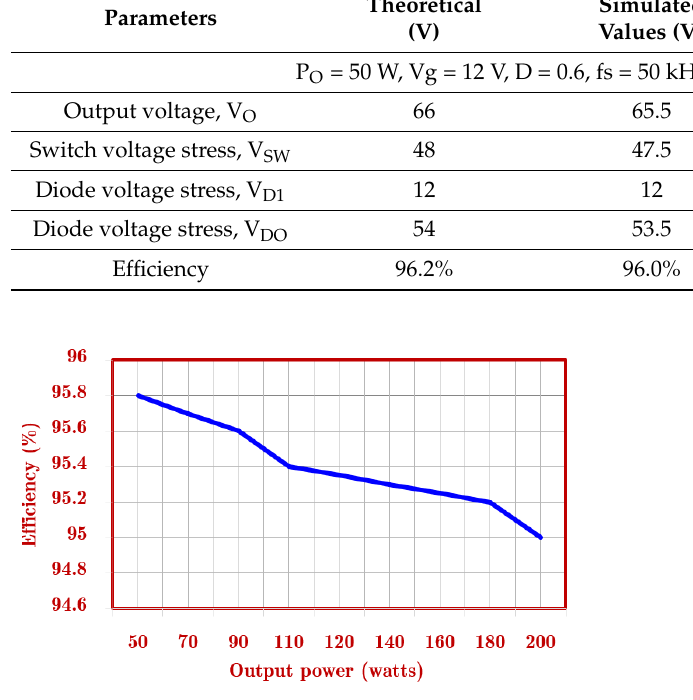
Figure 15. Efficiency versus output power. Table 6. Comparison between theoretical, simulation, and experimental results.